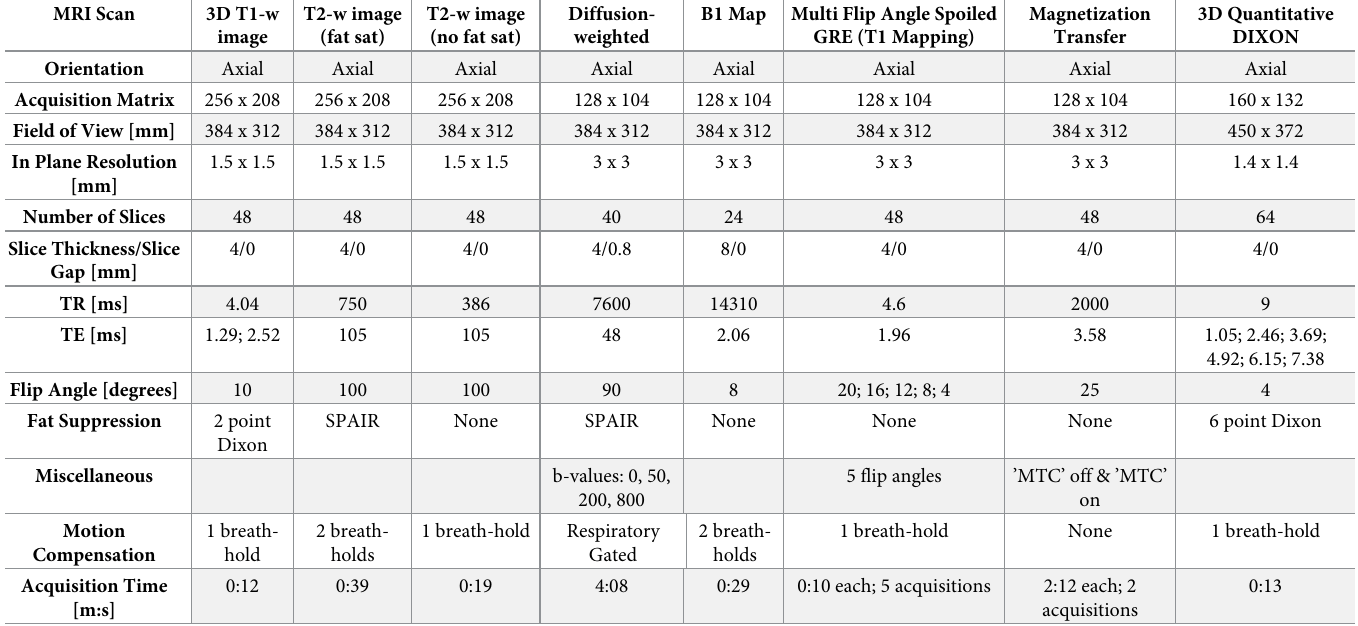
Table 1. MRI protocol acquisition